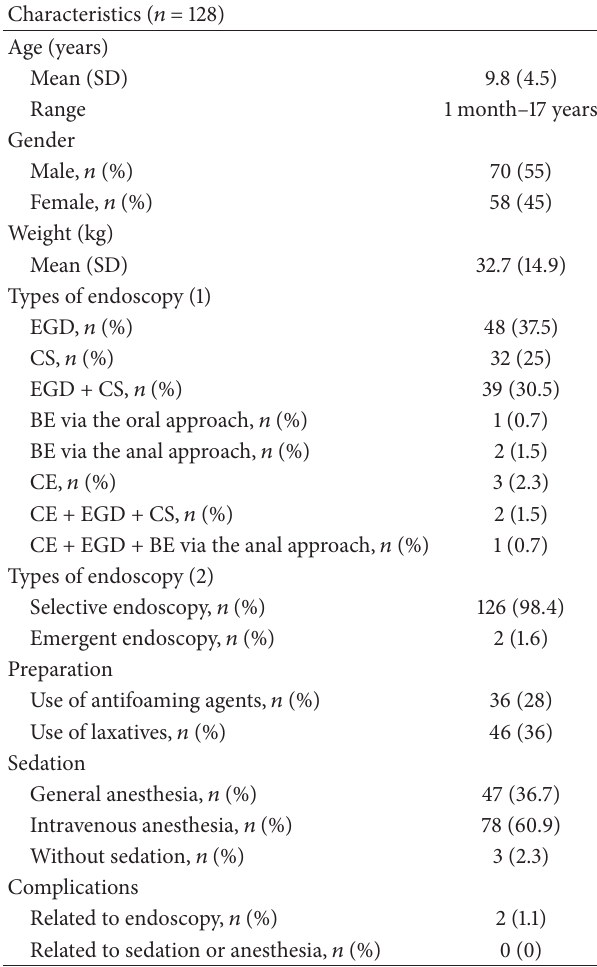
Table 1: Characteristics of the